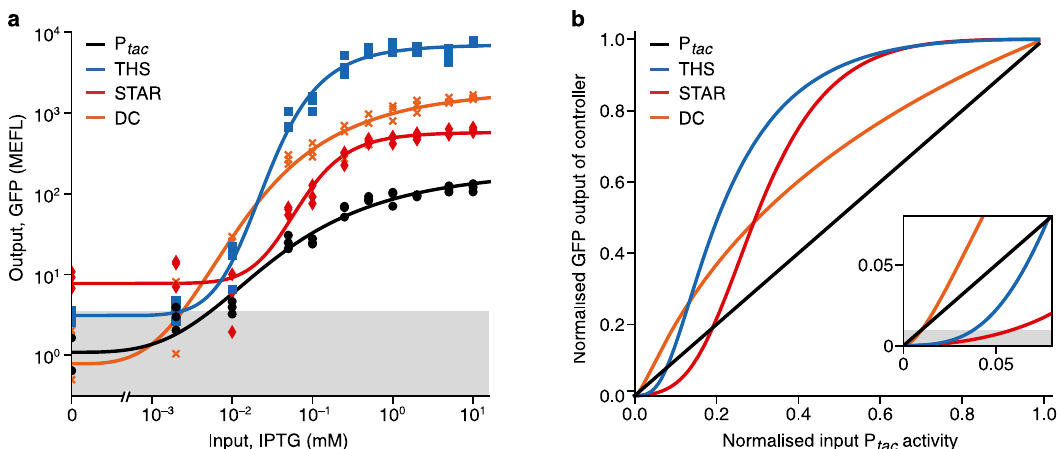
Fig. 4 Response functions of single- and multi-level controllers in vivo. a Steady-state response functions of the controllers showing output GFP fl uorescence (corrected for cell auto fl uorescence) for varying input IPTG concentrations (0, 0.002, 0.01, 0.05, 0.1, 0.25, 0.5, 1, 2, 5, 10 mM). Points show the three biological replicates for each controller and condition (black circles, P tac ; blue squares, THS; red diamonds, STAR; orange crosses, DC). Grey shaded region shows the standard deviation of cellular GFP auto fl uorescence from 11 biological replicates. b Comparison of how normalised GFP output (as a fraction of the maximum GFP fl uorescence) varies in response to changes in the normalised transcriptional activity of P tac (as a fraction of its maximum activity). Multi-level regulation can lead to the suppression or ampli fi cation of the output GFP production rate compared to direct transcriptional regulation (i.e. a speci fi c multi-level controller ’ s line falls below or above the diagonal, respectively). Insert shows zoomed area and grey shaded region denotes a GFP output level of 1% for the controller. Source data are provided as a Source Data fi